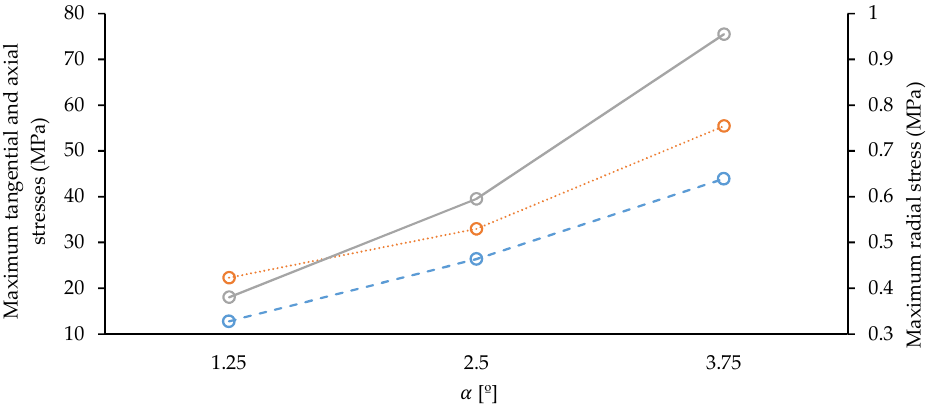
Figure 13. Maximum stresses on the grout material at the three directions: tangential (point line), axial (solid line), and radial (dashed line).